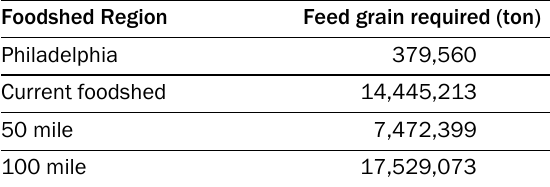
Table 7. Feed Grain Requirements